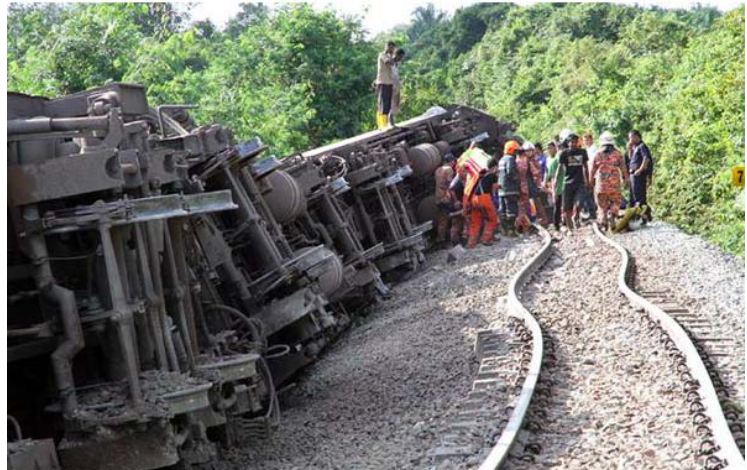
Figure 17. KTMB train derailed due to rail buckling and landed on its side, trapping the driver and injuring about five passengers just before Kempas, Johor station, southern part of Malaysia (Courtesy: Malaysia Department of Public Works).